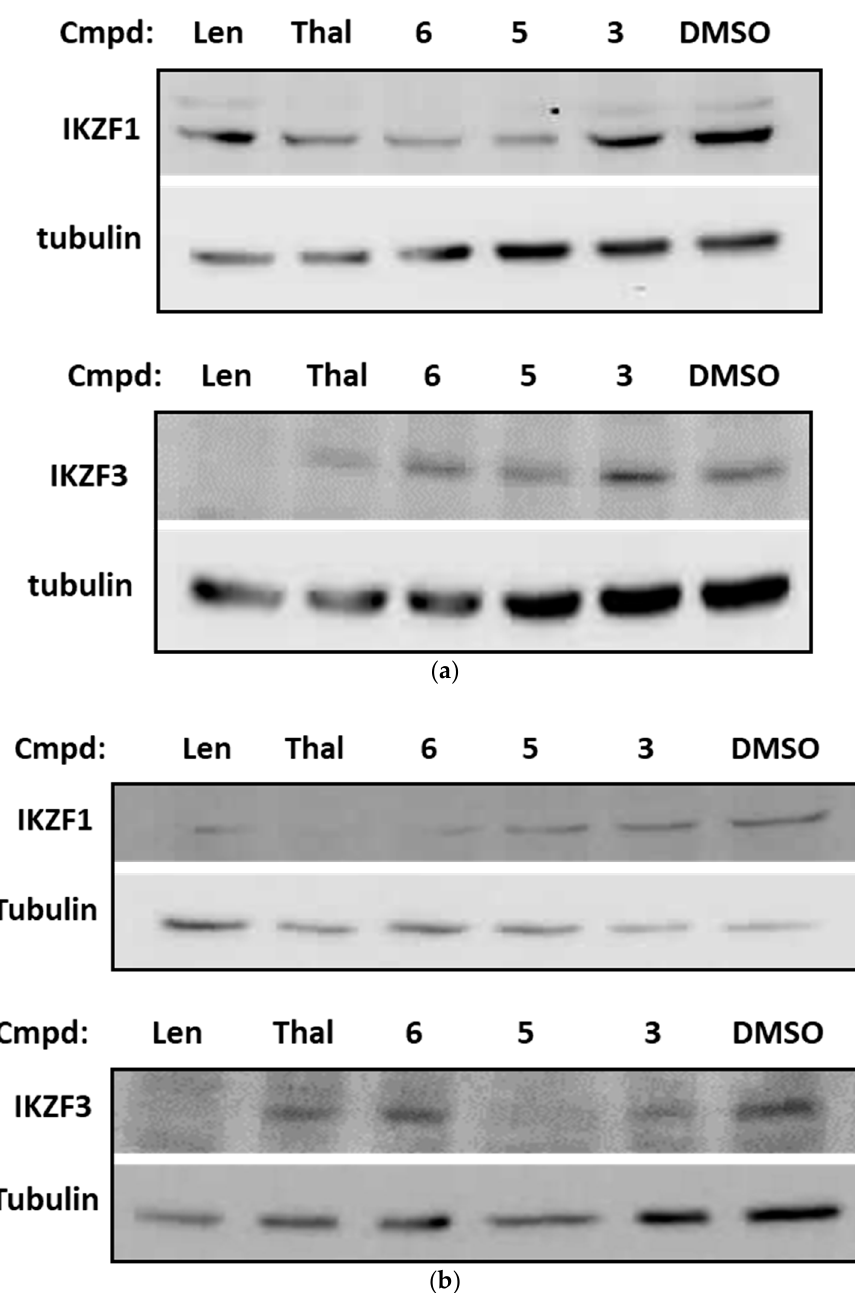
Figure 7. Dicarboximides downregulate the levels of IKZF1 and IKZF3 transcription factors in leukemia cells. ( a ) K562 cells treated with lenalidomide (10 μ M), thalidomide (100 μ M) and dicarboximides 3 (1 μ M), 5 (1 μ M) or 6 (1 μ M) for 48 h. ( b ) MOLT4 cells treated with lenalidomide (10 μ M), thalidomide (100 μ M) and dicarboximides 3 (5 μ M), 5 (10 μ M) or 6 (2 μ M) for 48 h. Representative blots from at least 3 independent experiments are